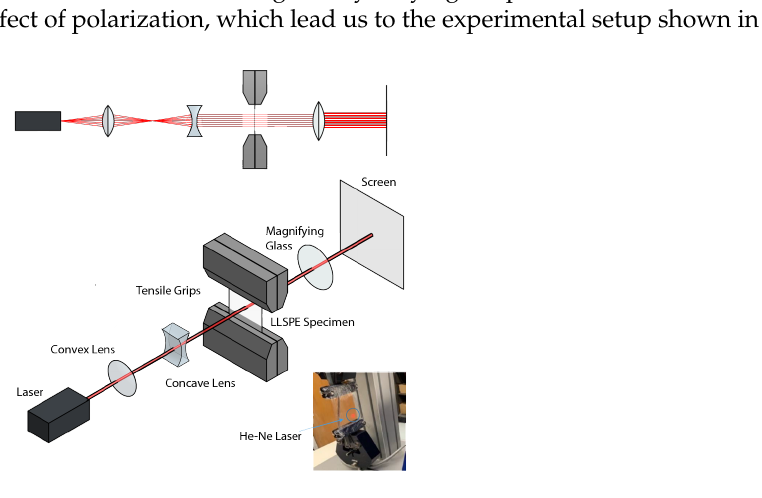
Figure 3. Experimental setup, showing the laser passing through the specimen.